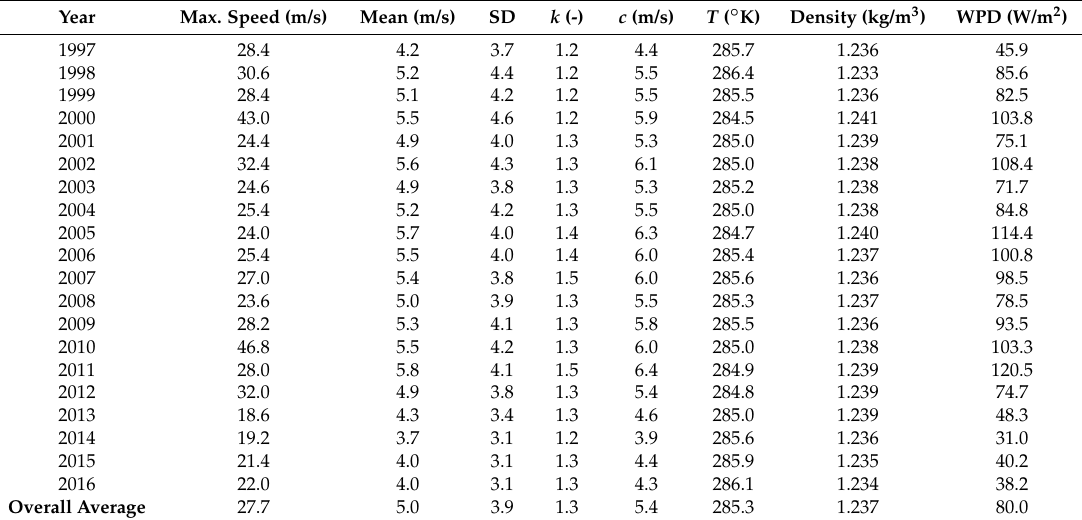
Table 4. Long term wind data analysis of Seo-San at 10 m from local ground.